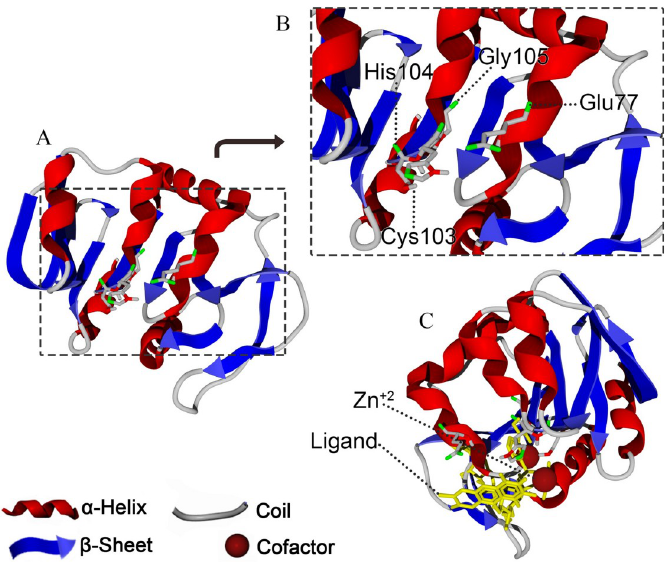
Fig 4. The exhibition of protease 1147 binding site. (A) Predicted 3D structure of protease 1147. (B) Amino acids belonging to the catalytic tetrad (Glu 77 –Cys 103 –His 104 –Gly 105 ), and (C) nucleophilic elbow, enzyme cofactor, and active site flap in protease 1147 active site.